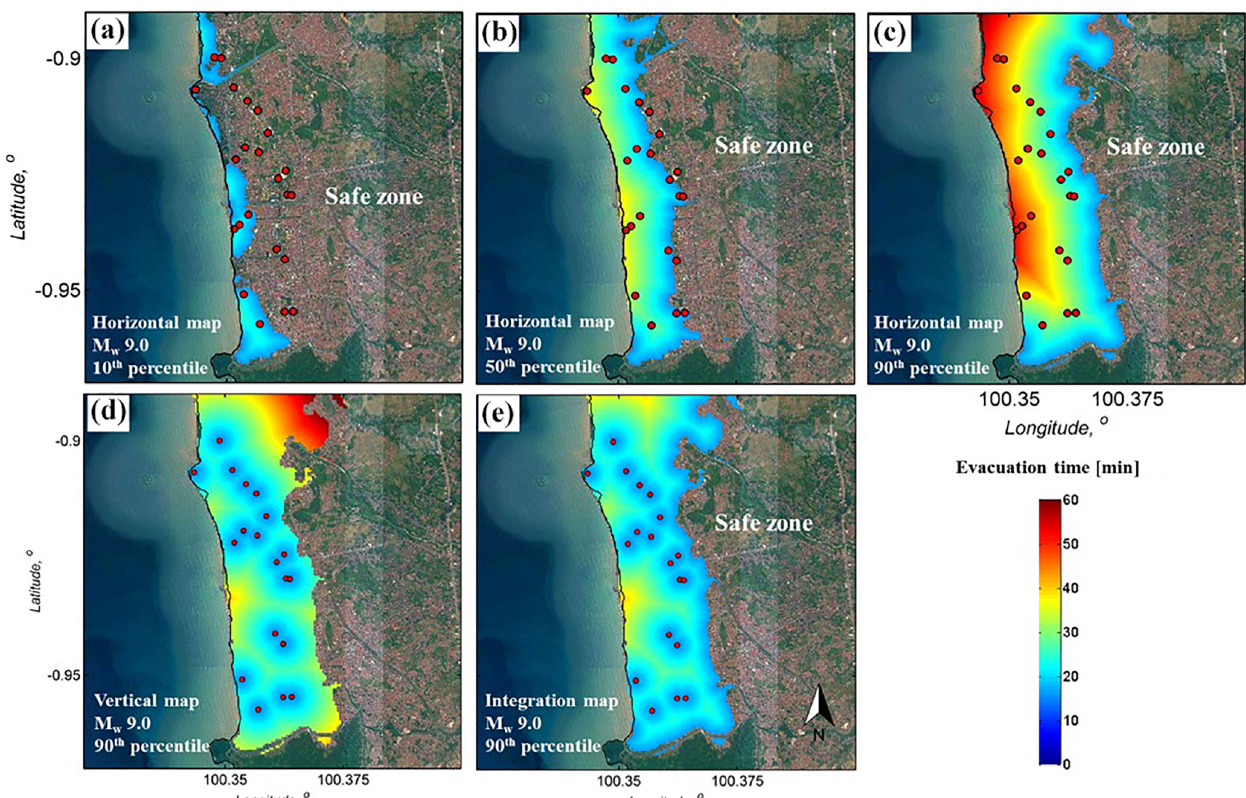
Figure 17. (a) Horizontal tsunami evacuation time maps in Padang for the 10th percentile. (b) Horizontal tsunami evacuation time maps in Padang for the 50th percentile. (c) Horizontal tsunami evacuation time maps in Padang for the 90th percentile. (d) Vertical tsunami evacuation time maps in Padang for the 90th percentile. (e) Integrated tsunami evacuation time maps in Padang for the 90th